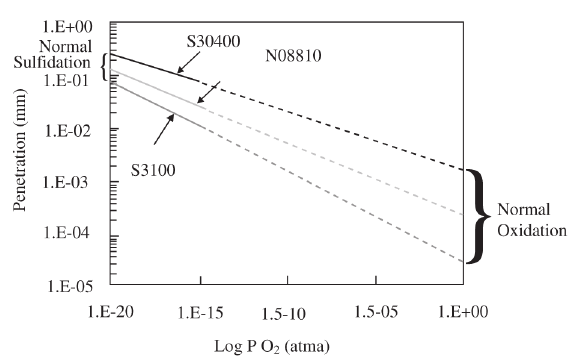
O or CO , as Indicated in the PO 2 2